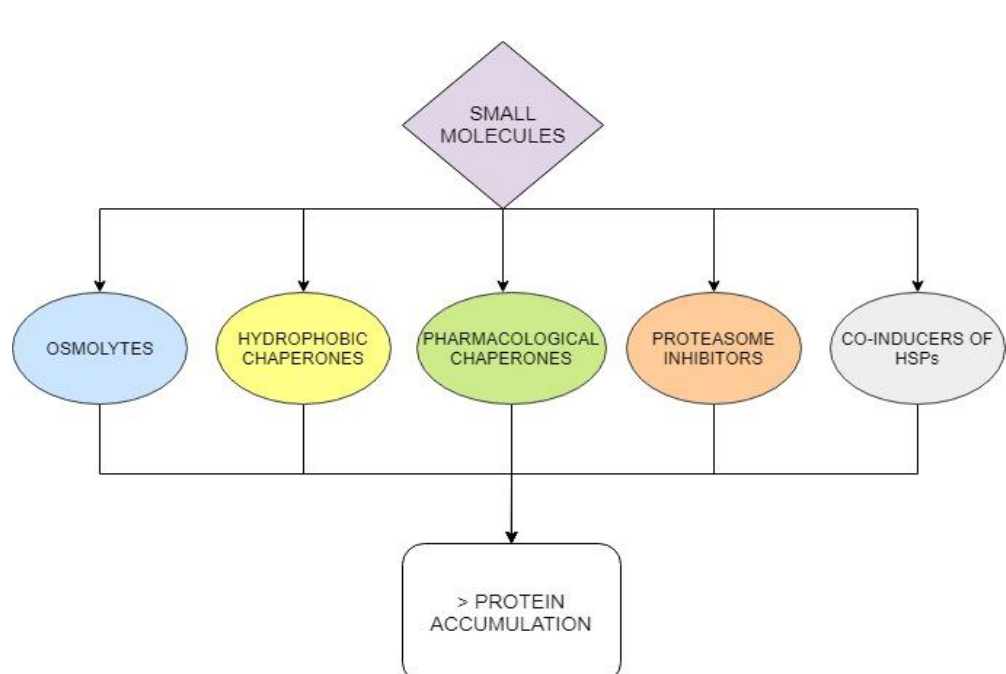
Figure 7. Different classes of small molecules can rescue proteins destabilized by mutations and increase their intracellular concentration.